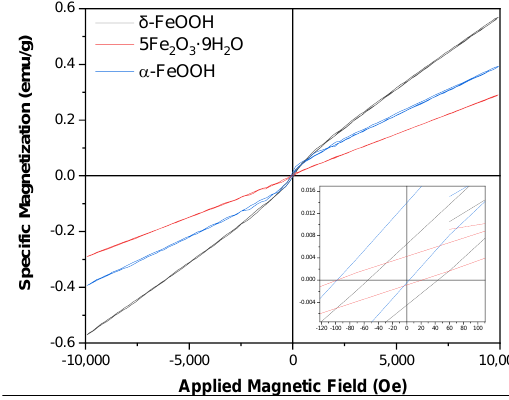
Figure 3. Magnetization curves of iron NP.